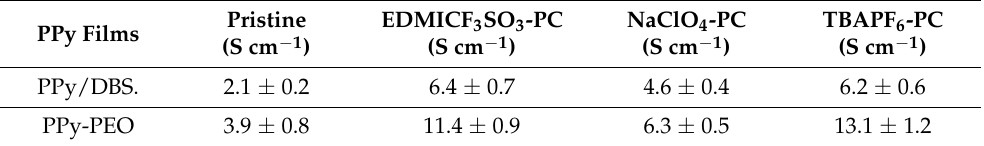
Figure 1. Galvanostatic electropolymerization (0.1 mA cm − 2 , − 20 ◦ C, 11.1 h) of PPy/DBS (red curve) and PPy-PEO (5 wt.% PEO, black curve) showing ( a ) potential E against time t. The SEM surface images (scale bar 30 µ m) with inset of cross-section image (scale bar 10 µ m) showing ( b ) PPy-PEO and ( c ) PPy/DBS films. Table 1. Electronic surface conductivities σ e of PPy/DBS and PPy-PEO films directly after polymer- ization (pristine) and after actuation studies in different